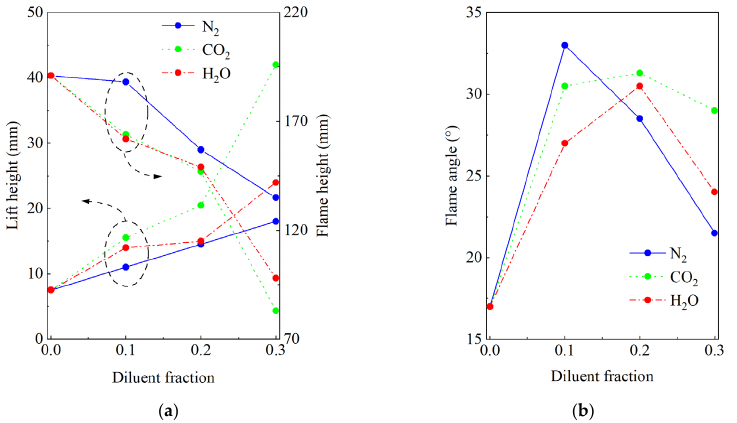
Figure 7. Variations in the liftoff height, flame height, and the flame angle with the diluent fraction. (( a ) shows the variation in the liftoff height and flame height, ( b ) shows the changes in flame angle. The vertical coordinate of the line segment in black dotted circle is the one indicated by the arrow.) The flame angle α refers to the angle between the tangential direction of the outer flame front and the central flame axis [27]. As seen from the data, unlike the liftoff height and flame height, the change in flame angle was nonmonotonic, enlarging and then down- sizing with increasing diluent fractions. Regardless of the diluent fraction, adding diluent expanded the gas volume flow compared to the F flame, forcing the flame to spread out in the radial direction. Prior work [27] revealed that the swirl number fluctuations mainly caused a change in the flame angle. Across the diluent fraction range of this study, the flame angle varied over a small range within 15°. A combined analysis of H L , H, and α showed that the diluent caused the flame’s dimensional reduction and radial spread. This tendency to change the flame shape intensified as the diluent fraction increased. Com- pared with the N 2 and H 2 O diluents, the CO 2 diluent had a more pronounced effect on the flame. 3.2. Effect of the Diluents on the NO Formation Characteristics Figure 8 represents the NO generation of the F, FN, FC, and FH flames. The data showed that the NO generation reduced with the increase in the diluent fraction. At a diluent fraction of 0.3, the NO generation for the H 2 O diluent was 62 ppm, which was 69% lower than that observed without a diluent. In addition, it was 47% and 32% lower than that observed with the CO 2 and N 2 diluents, respectively. The NO production routes mainly include the Zeldovich thermal route, the NNH intermediate route, and the N 2 O intermediate route. Because Figure 4 showed that the flame temperature for the N 2 diluent was higher than that of the CO 2 and H 2 O diluent, the N 2 -diluted flame generated more NO by the thermal route. Considering the CO 2 and H 2 O diluents, the temperature level and NO production showed contradictory relationships, whereby the CO 2 diluent showed a lower temperature but a higher NO generation than the H 2 O diluent. This was attributed to the fact that when CO 2 was added, more O radicals were generated than H 2 O, further promoting the reactions of N + NO = N 2 + O, NH + O = H + NO, and NNH + O = NO + NH to generate NO. N + NO = N 2 + O generated NO while generating N radicals. Further, the N radicals promoted the reactions of N + O 2 = NO + O, N + OH = NO + H, and N + CO 2 = NO + CO to produce more NO [10]. From this route analysis, it is clear that the NO pro- duction from the FC flames was significantly influenced by the concentration of the reac- tants, which inevitably caused a change in the correlation between the temperature and